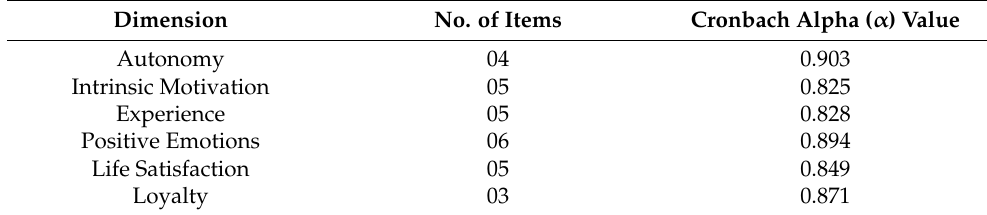
Table 1. Results of Reliability Test.